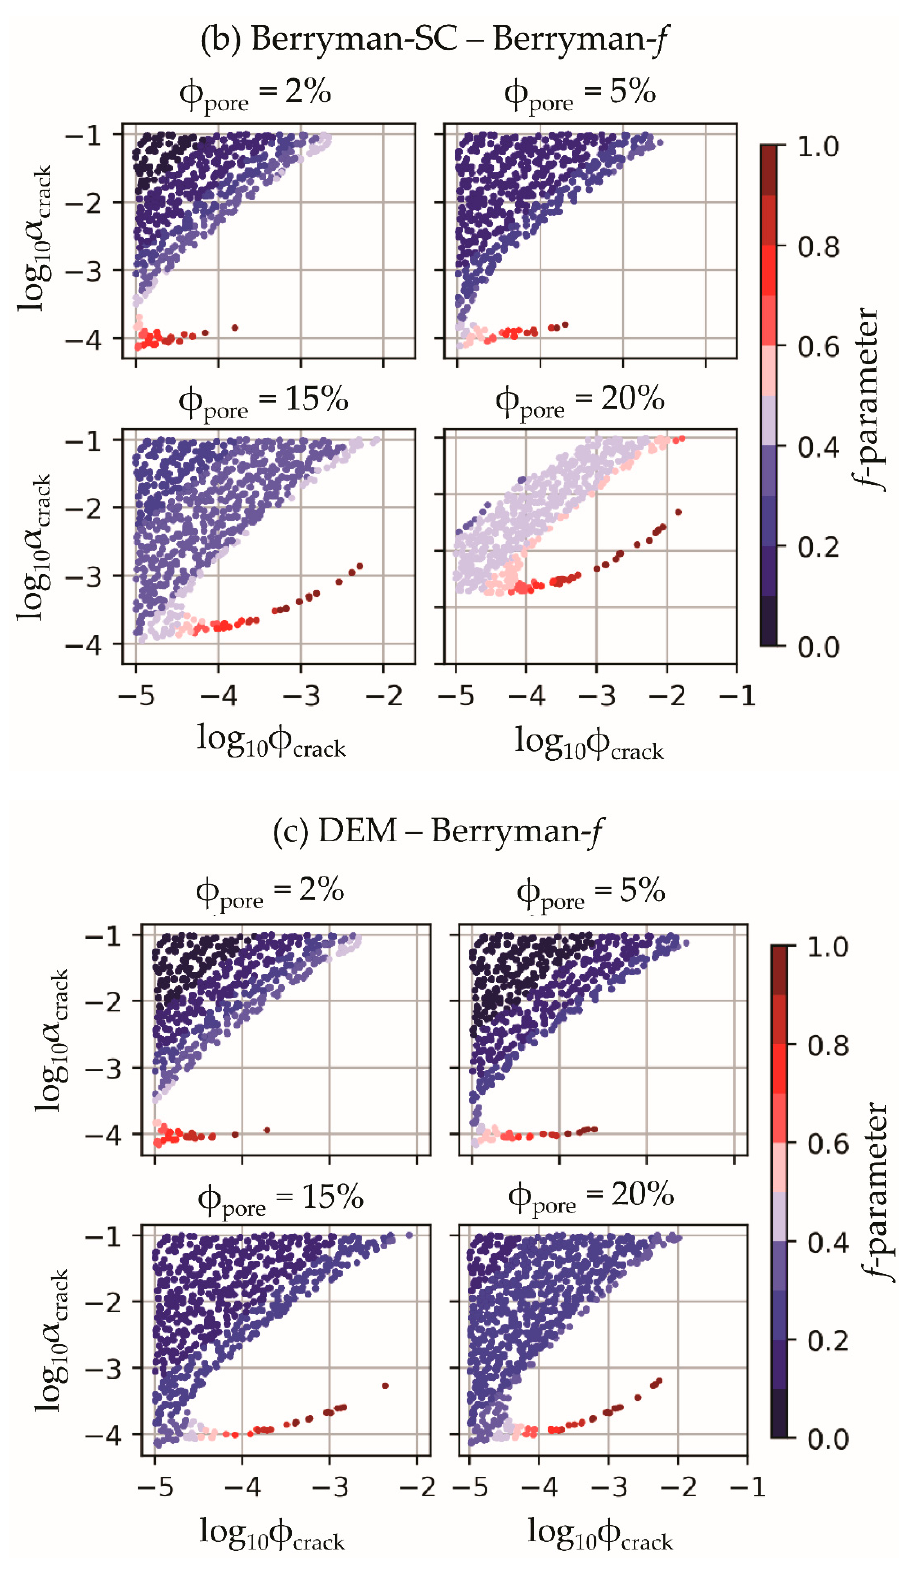
Figure 3. Crack aspect ratio and crack porosity vs. f -parameter as a color for fixed spherical porosity values. Voids are saturated with gas. Calculations are performed for three pairs of methods: ( a ) GSA-SC − GSA- f , ( b ) Berryman-SC − Berryman- f , and ( c ) DEM − Berryman- f. Each color point is related to a solution for aspect ratio and crack porosity provided by Type 1 model. The color is controlled by the f -parameter value provided by Type 2 model.